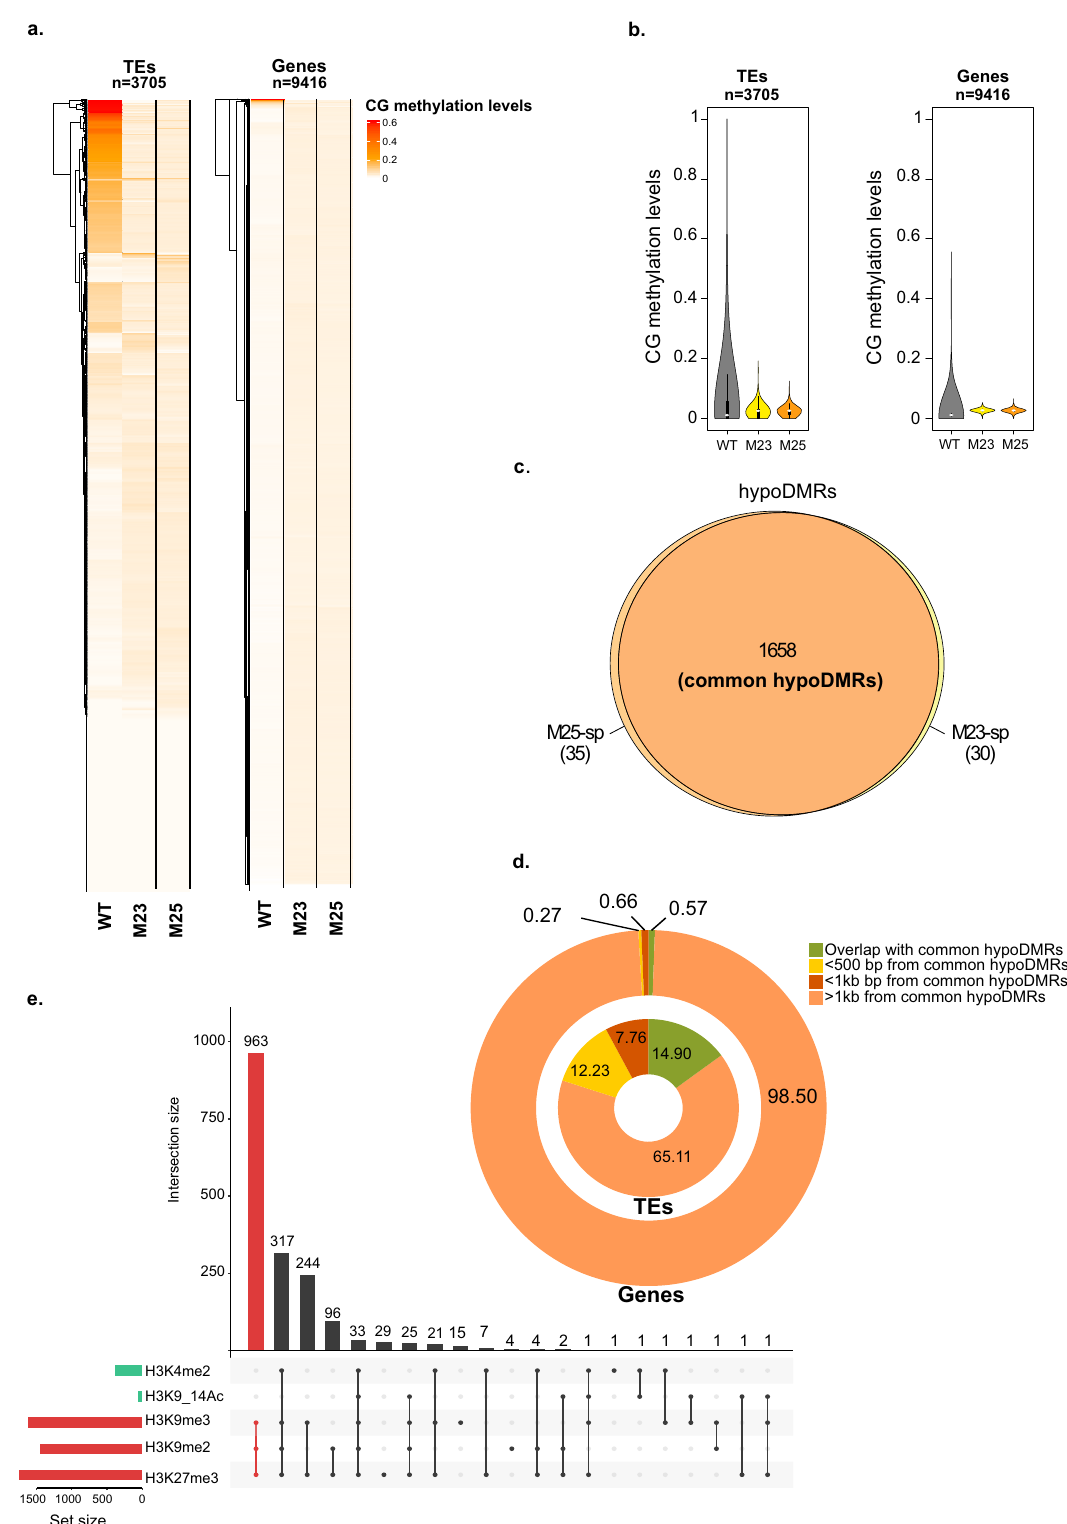
Fig. 3 CG methylation pro fi les in DNMT5:KO cell lines. a Heatmap of CG methylation levels in Pt1 8.6 reference (WT), M23 and M25 for TEs (left panel) and genes (right panel). b Violin plot showing the methylation levels in all CGs found in TEs and genes in Pt1 8.6 and M25, M23. Box plots: the bottom of the box displays the lower quartile, the upper part, the upper quartile and the white dots show the median. c Venn diagram displaying the number of hypoDMRs identi fi ed in M23 (M23-spe) (yellow) and M25 (M25-spe) (orange). d Percentages of overlap between common hypoDMRs, genes and TEs. e Association between common hypoDMRs and regions targeted by histone post-translational modi fi cations representative of the epigenetic landscape of P. tricornutum . The number of overlapping common hypoDMRs is shown for each histone modi fi cation and each combination of histone modi fi